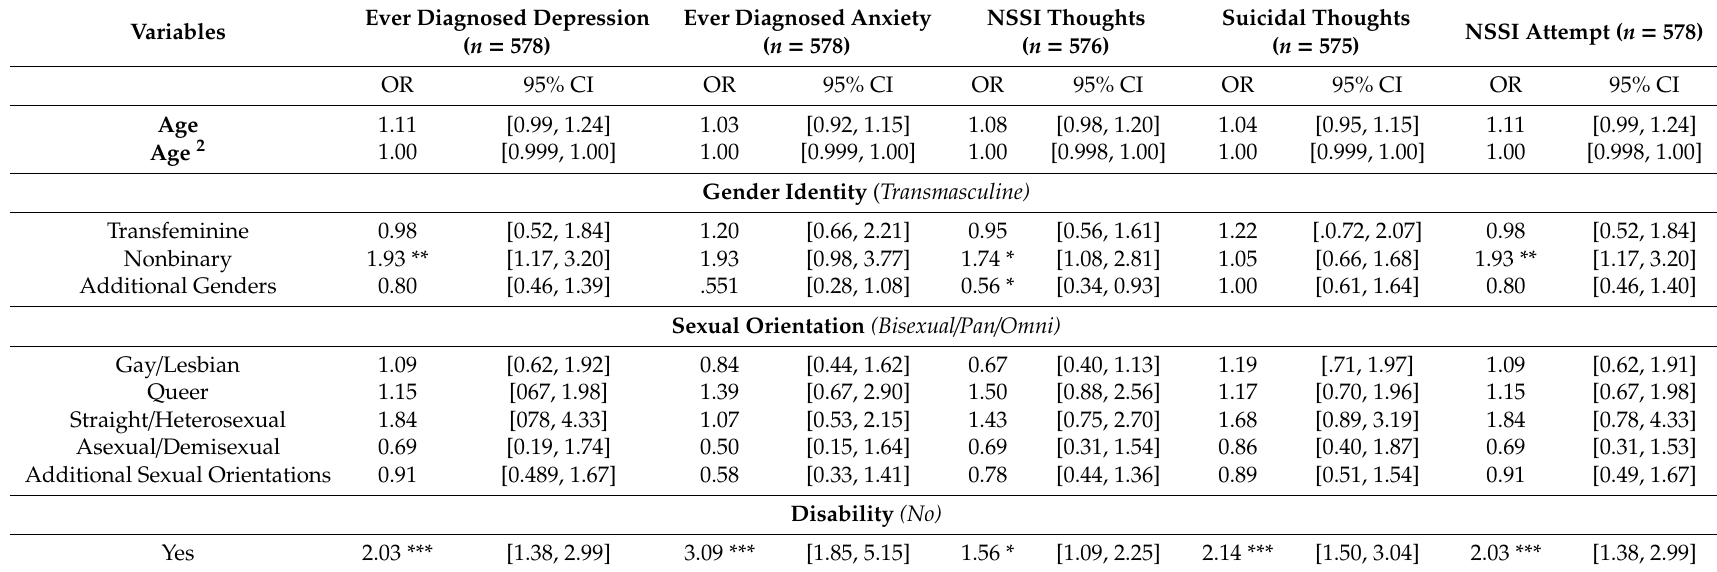
Table 3. Binary Logistic Regressions of Mental Health